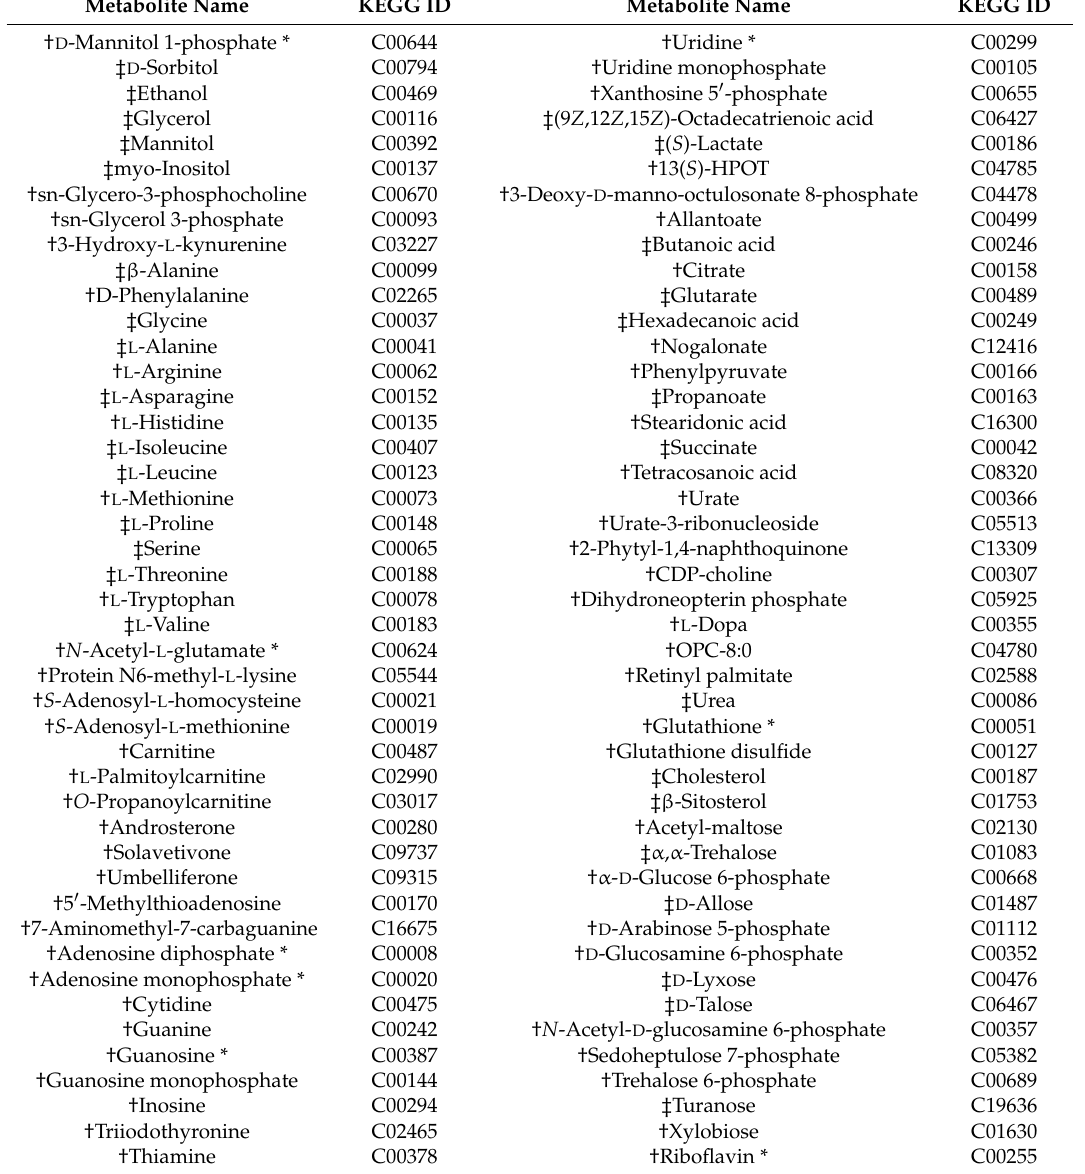
Table 1. The metabolites identified by GC-MS and